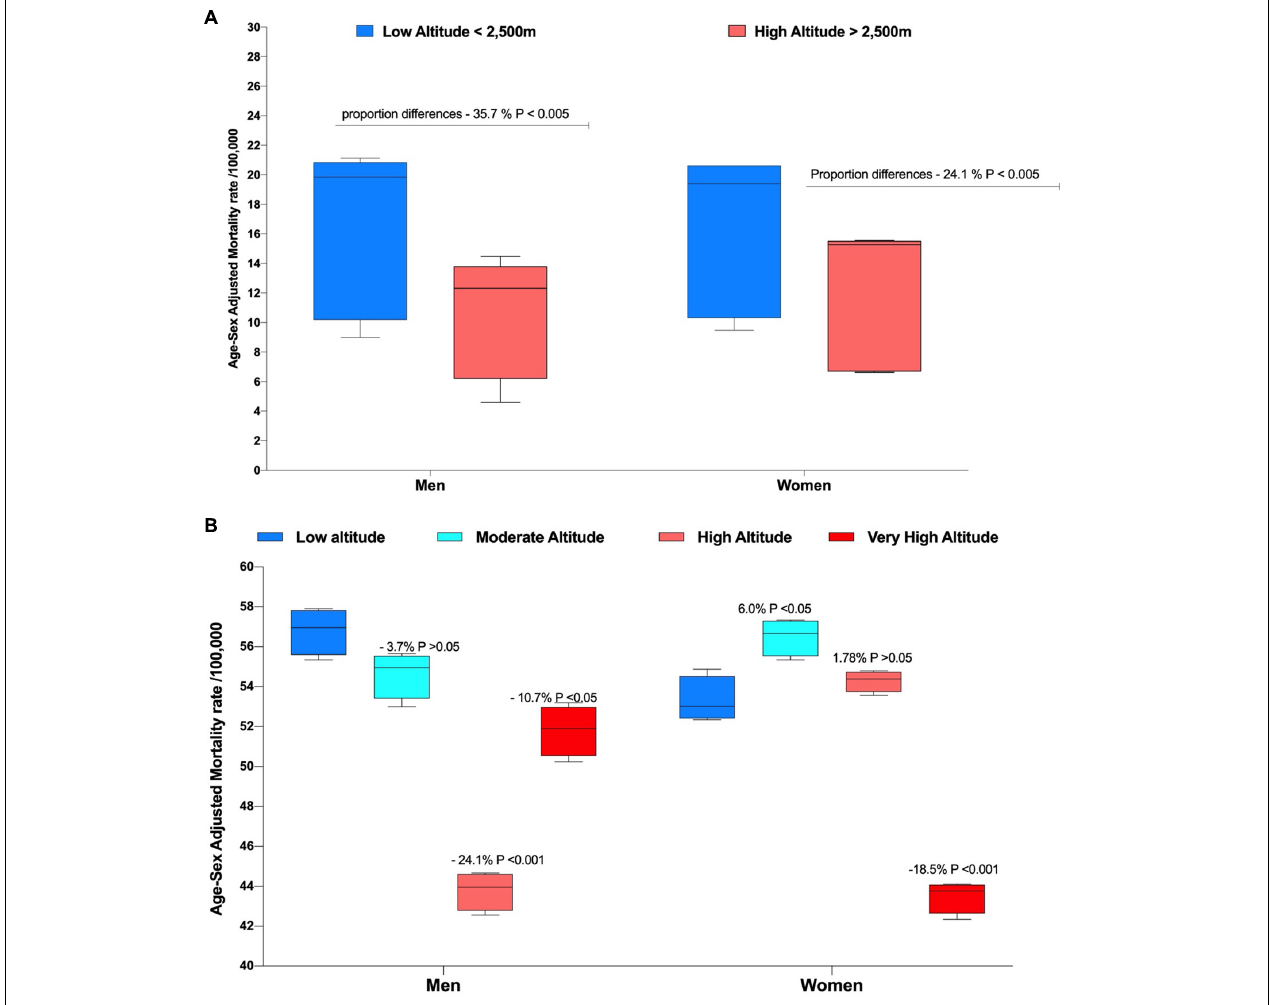
FIGURE 3 | Overall age and sex-adjusted mortality rate by sex and elevation exposure. (A) Low altitude ( < 2,500 m) and High altitude ( > 2,500 m) Classification and (B) Low altitude ( < 1,500 m), Moderate altitude (1,500 − 2,500 m), High altitude (2,500 m − 3,500 m) and Very High altitude (3,500 m − 5,500